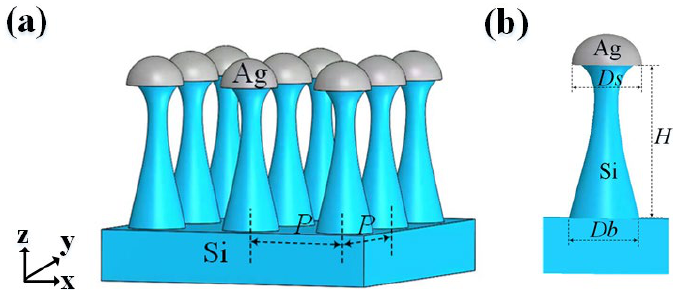
Figure 1. ( a ) Schematic diagram of the proposed mushroom-nanostructured arrays; ( b ) 2D view of the nanostructure with Ag NPs in a unit